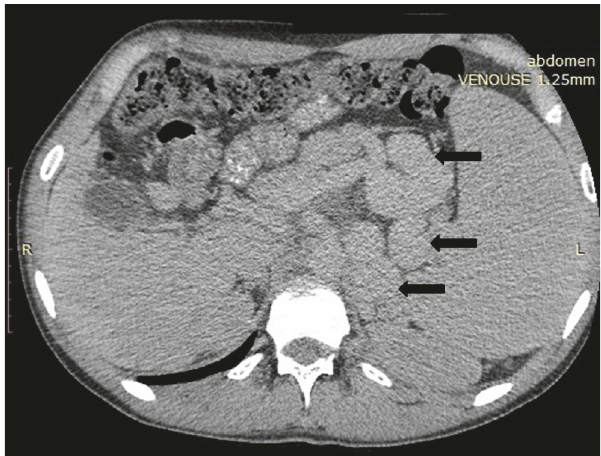
Figure 2:PASx 300Glomeruluswith lobularpresentation,widened mesangium, and thickened capillary